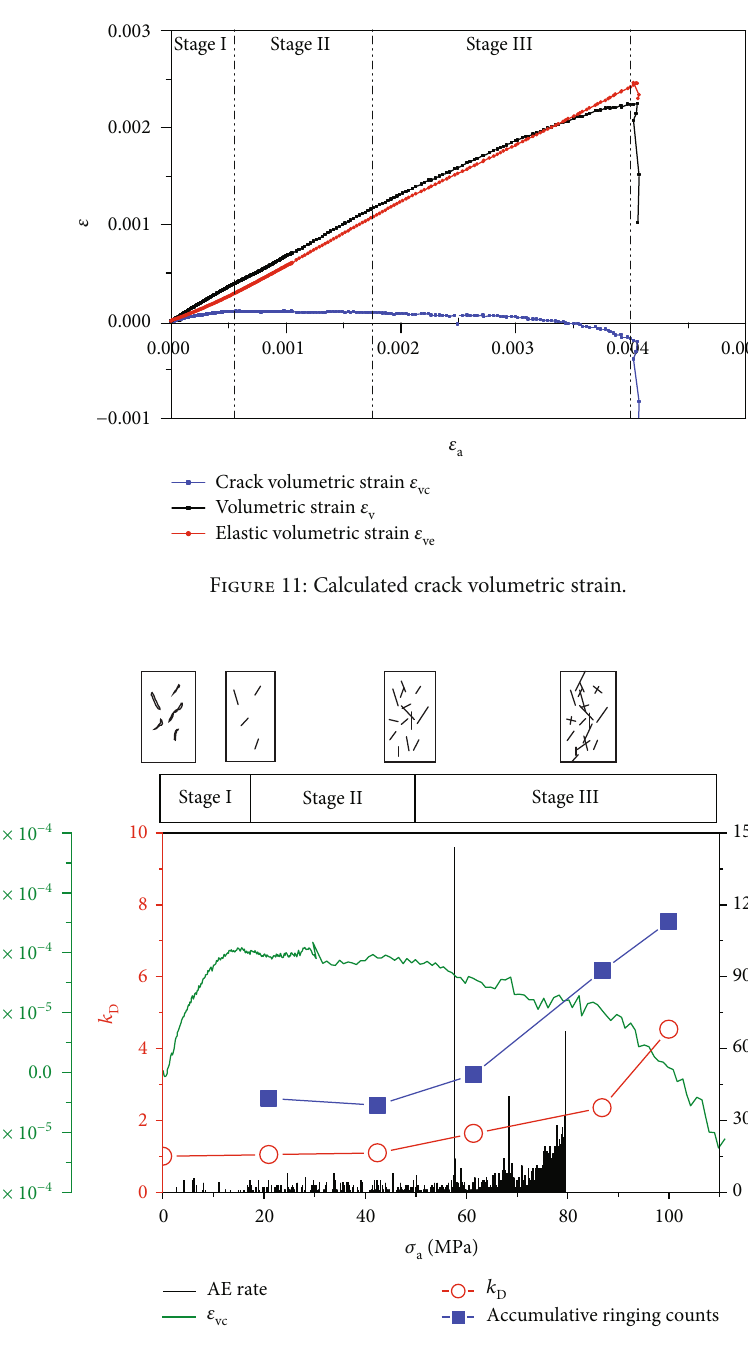
Figure 12: The model diagram of AE characteristics, crack propagation, and permeability